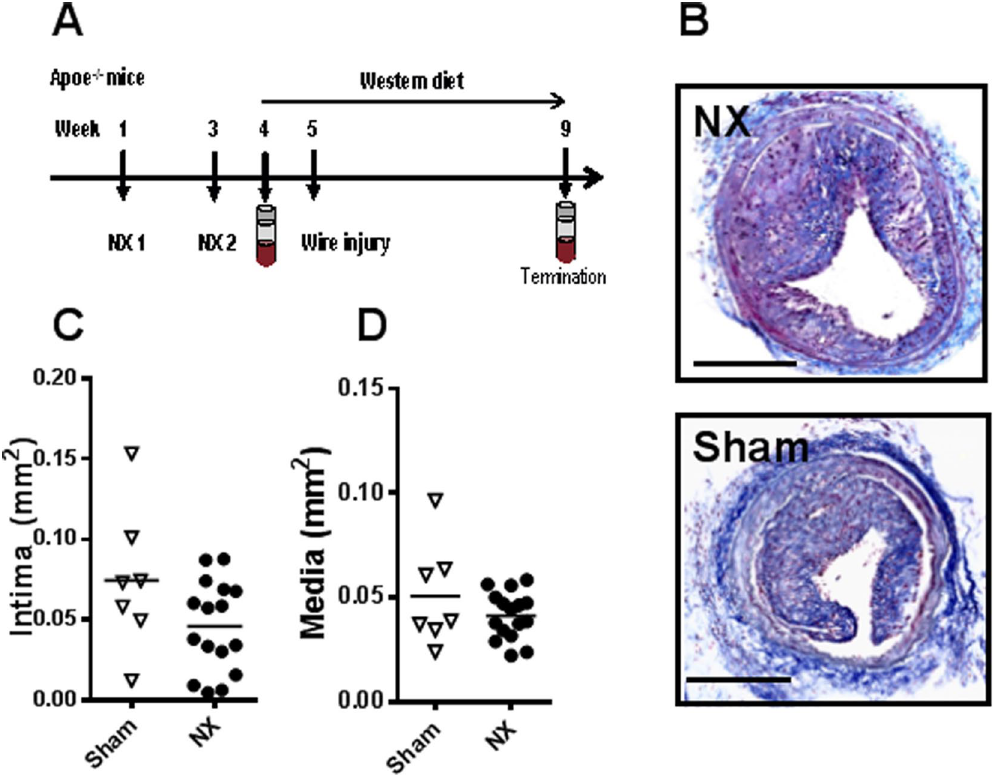
Figure 4. Uremia does not affect neointima formation in carotid arteries after vascular injury in Apoe − / − mice. ( A ) Study outline: Apoe − / − mice underwent 5/6 nephrectomy (NX) or sham operation (sham) in two steps (timepoints NX1 and NX2), were put on a western diet, and subsequently underwent carotid wire injury. B . Representative pictures of Trichrome stained injured carotid arteries from NX and sham Apoe − / − mice. Scale bar, 200 μ m. ( C ) Histological quantification of cross-sectional intimal and ( D ) medial area in injured carotid arteries from NX and sham Apoe − / − mice (average of 8–12 sections per mouse; n = 16 NX, n = 7 sham), four weeks after wire injury. Horizontal bars represent mean values. Upaired